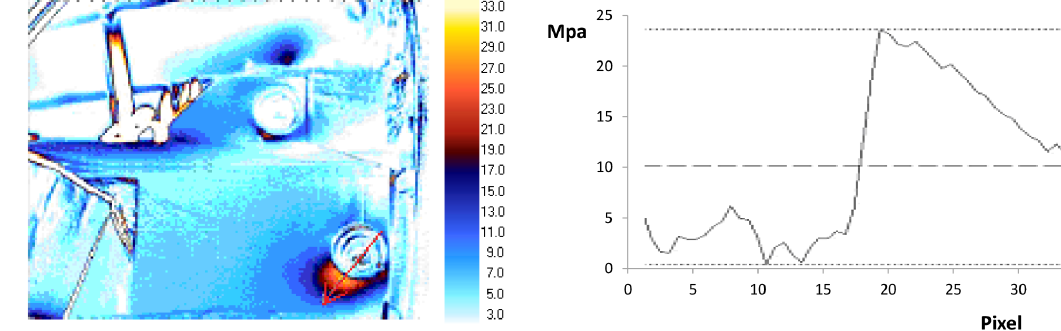
Figure 5. Thermoelastic stress